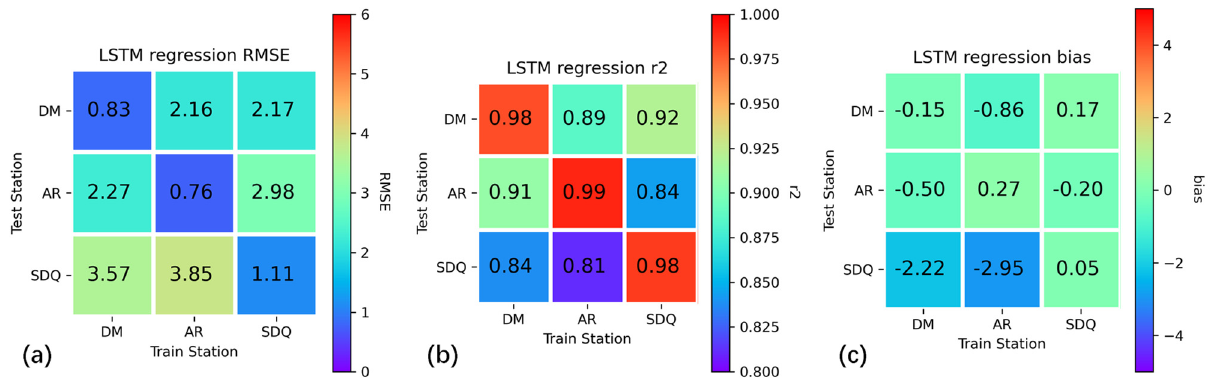
Figure 11. The RMSEs of predicted results by LSTM regression method using training and test data from cross stations during different years. ( a – c ) correspond to RMSE, R 2 , and bias, respectively.